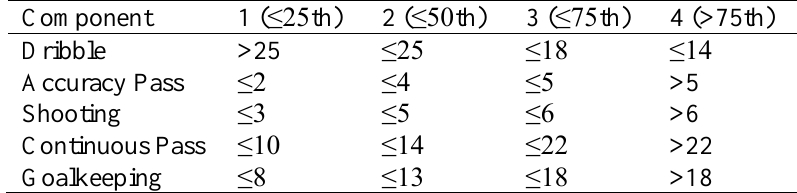
Table 2. BFST-AVI raw score to quartile score conversion table.